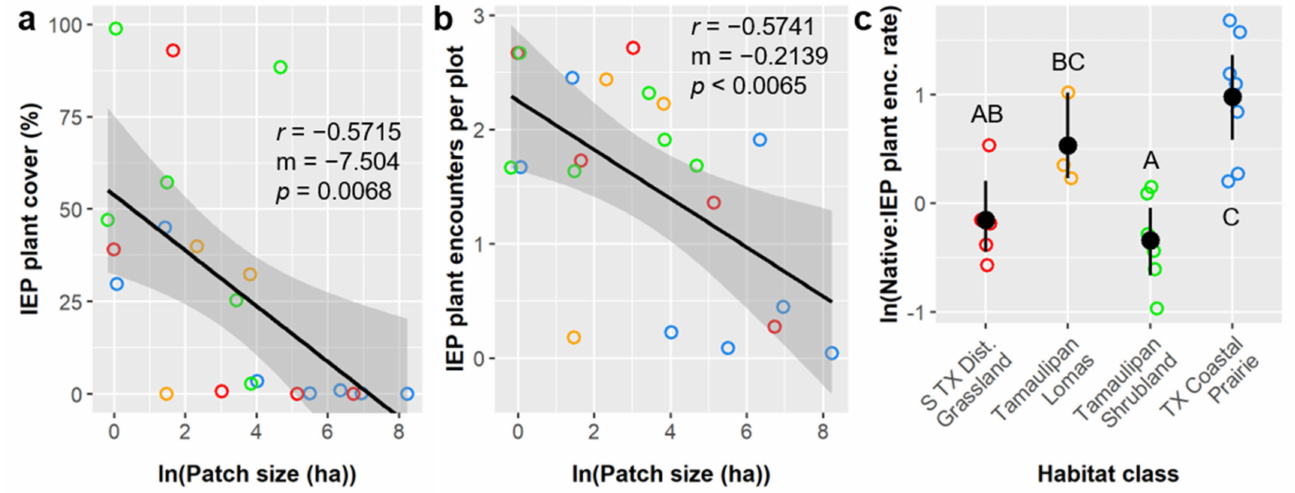
Figure 4. Linear relationships between habitat patch size and ( a ) combined invasive, exotic, and pest (IEP) plant cover and ( b ) IEP plant encounter rate. ( c ) Treatment means with 95% confidence intervals showing the effects of habitat class on the natural log of the ratio of native to IEP plant encounter rates. Open circles denote values from one study site and are colored to denote habitat class as follows: red, S TX Disturbed Grassland; orange, Tamaulipan Lomas; green, Tamaulipan Shrubland; blue, Texas Coastal Prairies. Legend: r , Pearson correlation coefficient; m, slope from the regression model (effect size); p , p -value from the regression model (see Table S4 for p -values from the ANCOVA model). Capital letters in panel c denote the results of least square means post hoc tests; groups that share a letter were not significantly